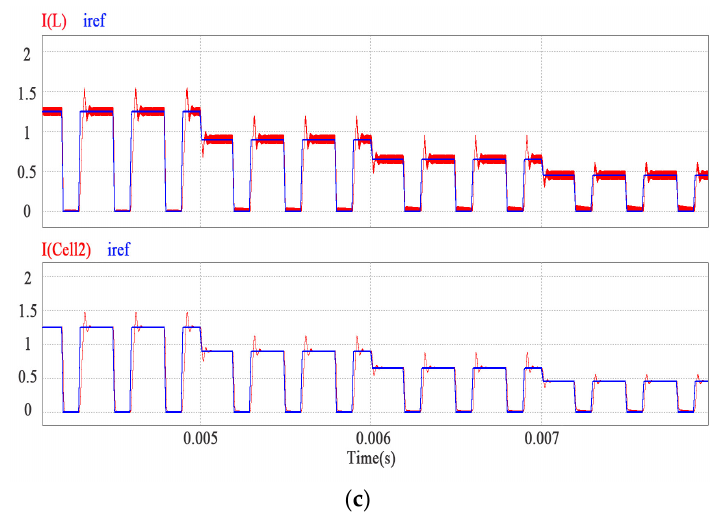
Figure 8. Simulation waveforms results: ( a ) buck inductor current i L , reference current i ref , gating signal of buck switch V g ; ( b ) charging current i cell 2 , reference current i ref , buck inductor current i L ,